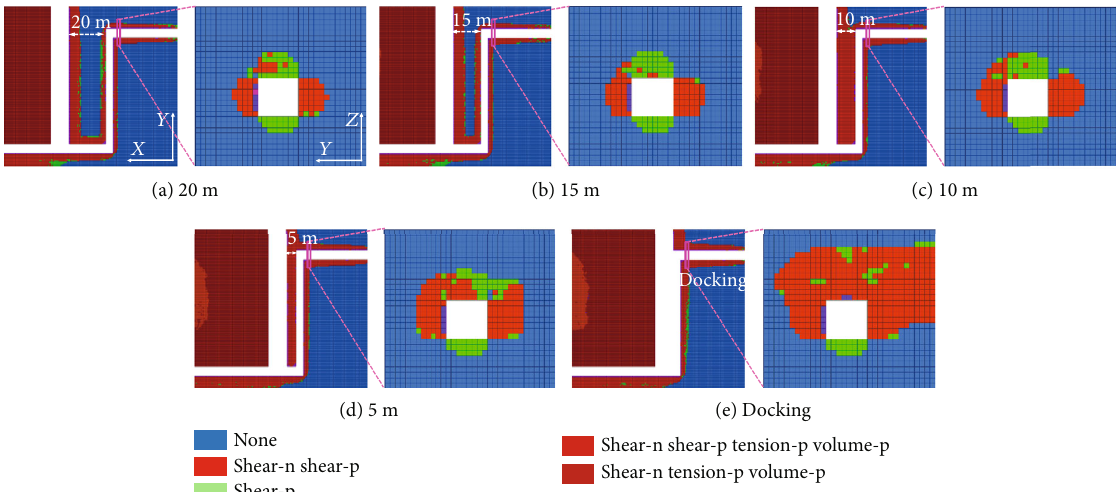
Figure 15: Evolution diagram of plastic zone distribution characteristics of docking